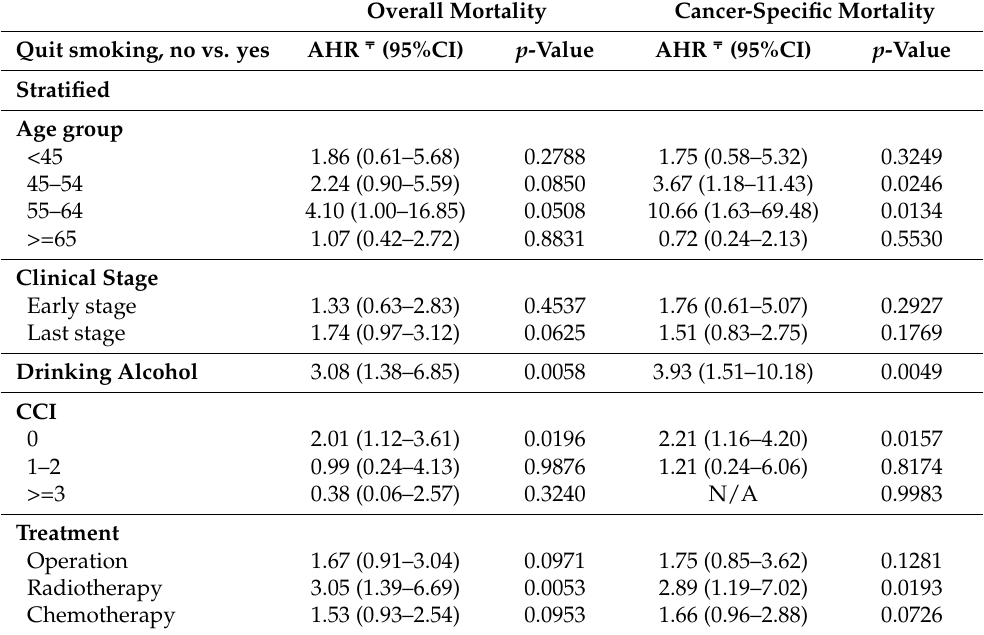
Table 2. The risk of mortality between smokers and non-smokers among women with breast cancer stratified by Table 4. The stratified analysis of mortality risk between women who quit smoking and those who did not.